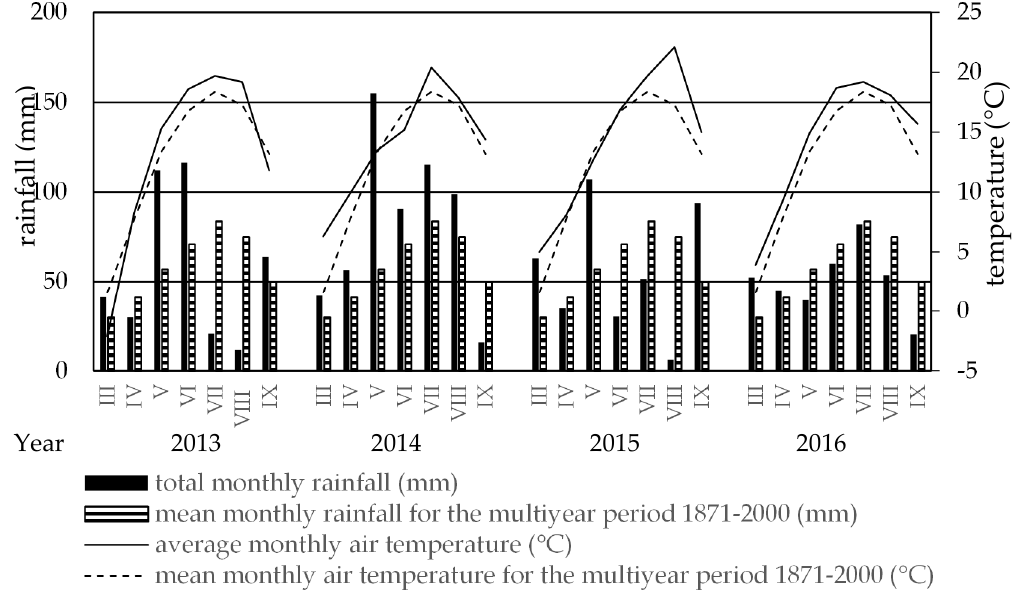
Figure 1. Meteorological conditions in the years 2013–2016 at Grabów (Poland) during the growing season.